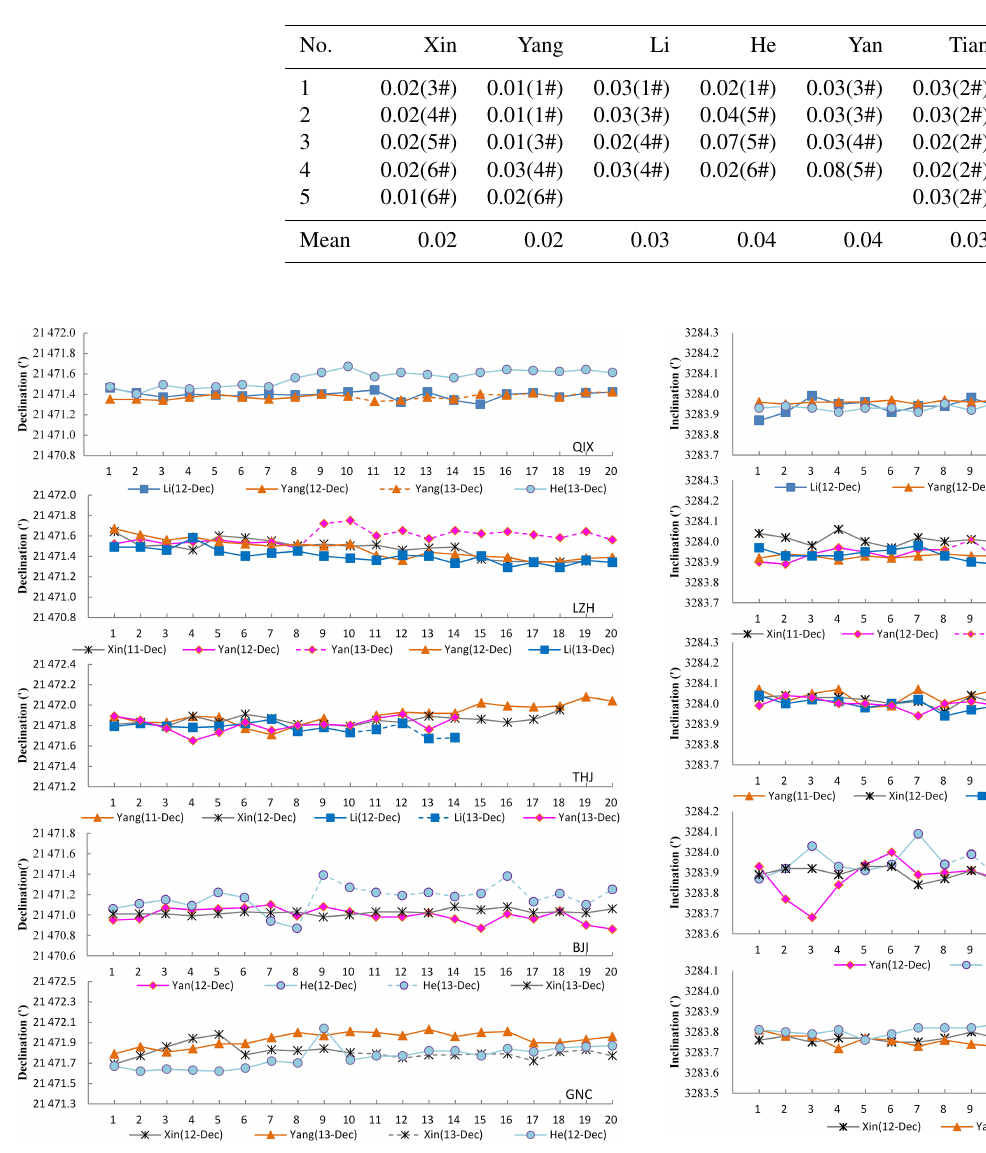
Figure 3. The baselines for inclination measurements. Different symbols (or colors) represent different observers, and different line styles represent that the same observer made absolute measure- ments on different observation